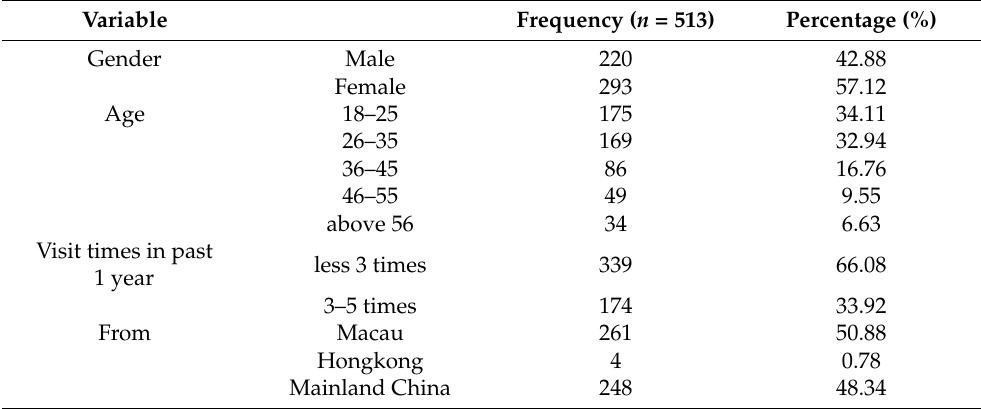
Table 1. Demographic Profile of